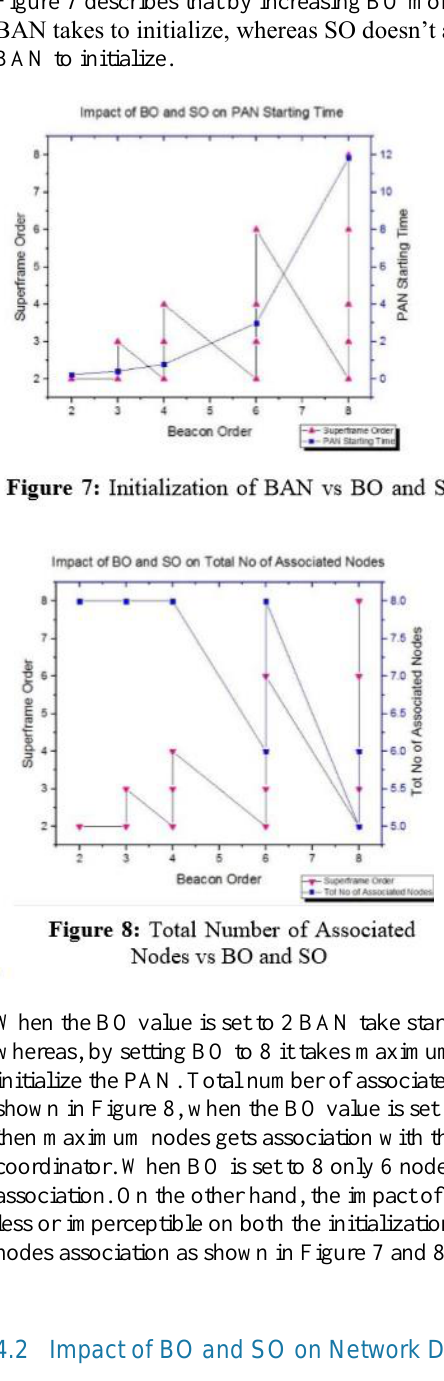
Figure 9, 10, and 11 minimum, maximum and average delay is plotted. The graphs show that the delay is minimum near to zero when the value of BO and SO is equal. Increasing delay is lowering SO. Decreasing the SO decreasing the active part of the superframe, causing increment in